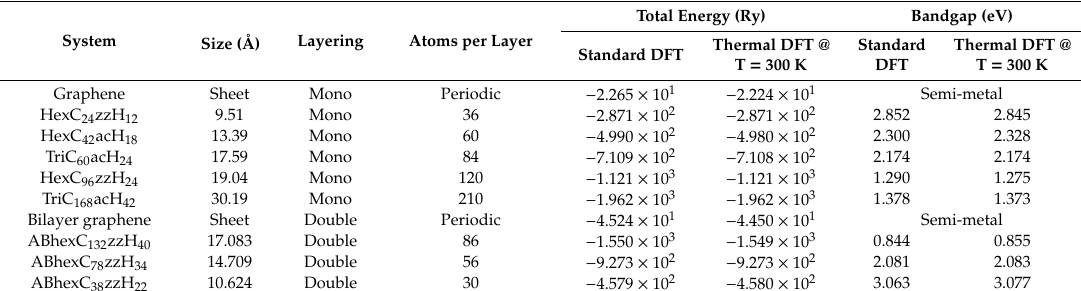
Table 2. Comparing the various GQD bandgaps from our DFT calculations with those from other works using di ff erent